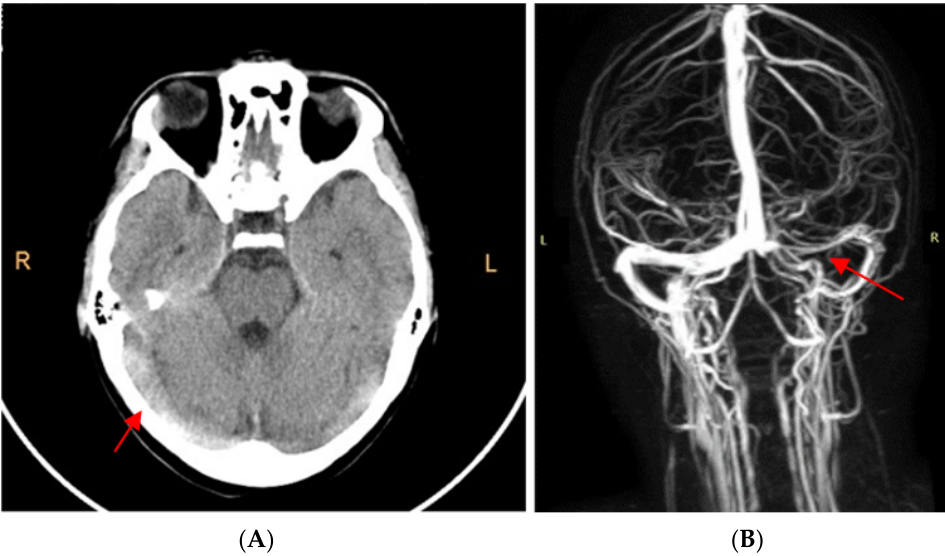
Figure 1. ( A ). CT scan without contrast: highlighted hyperdensity of the internal cerebral veins raised the suspicion of cerebral venous thrombosis. ( B ). MRI angiography: extended cerebral venous thrombosis affecting the right sigmoid sinus, both transverse sinuses, their point of confluence, and the right internal jugular vein.